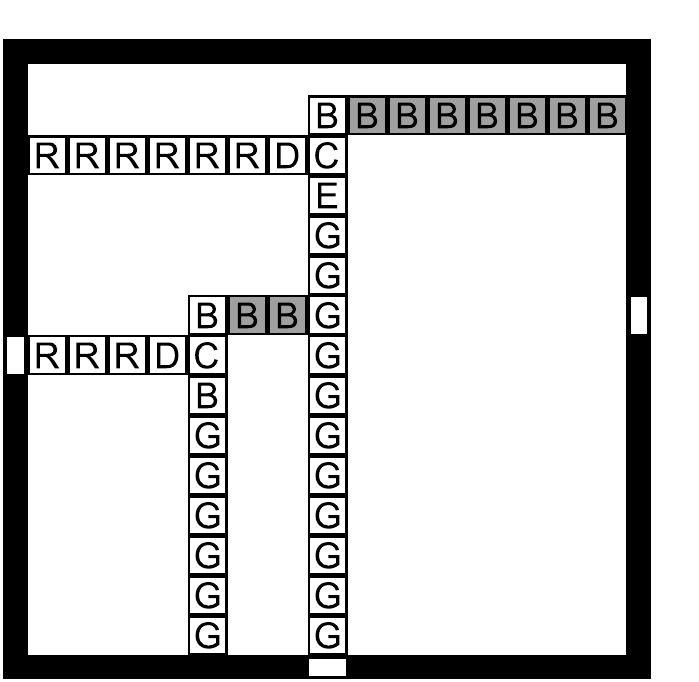
Fig 6. Past the point of cooperation, these phantom signals may or may not block one another, compounding the rate of error